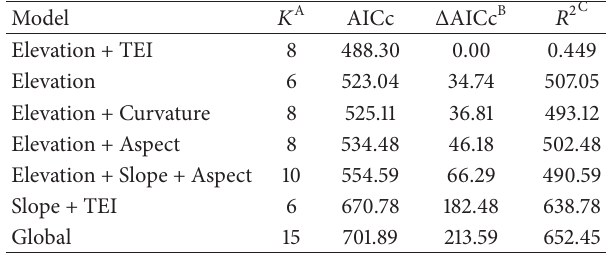
Table 2: Logistic regression models explaining the influence of terrain variables on the presence or absence of northern hardwoods (NH) in the areas above 1219.2.2 m in elevation of western North Carolina, eastern Tennessee, and southwest Virginia which com- posed our study area ( 𝑛 = 332 ). Sampling took place between June 2012 and January 2013. Model rankings were based on Akaike’s information criterion corrected for small sample size